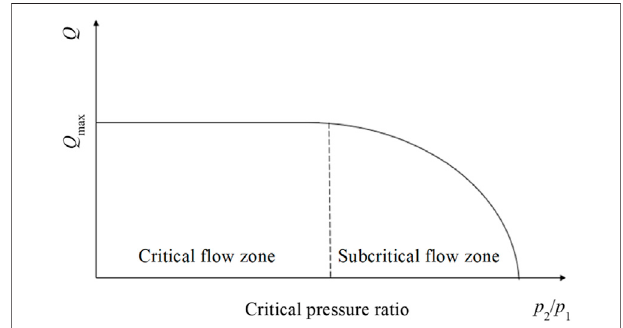
FIGURE 3 | Relation graph of natural gas pressure ratio and